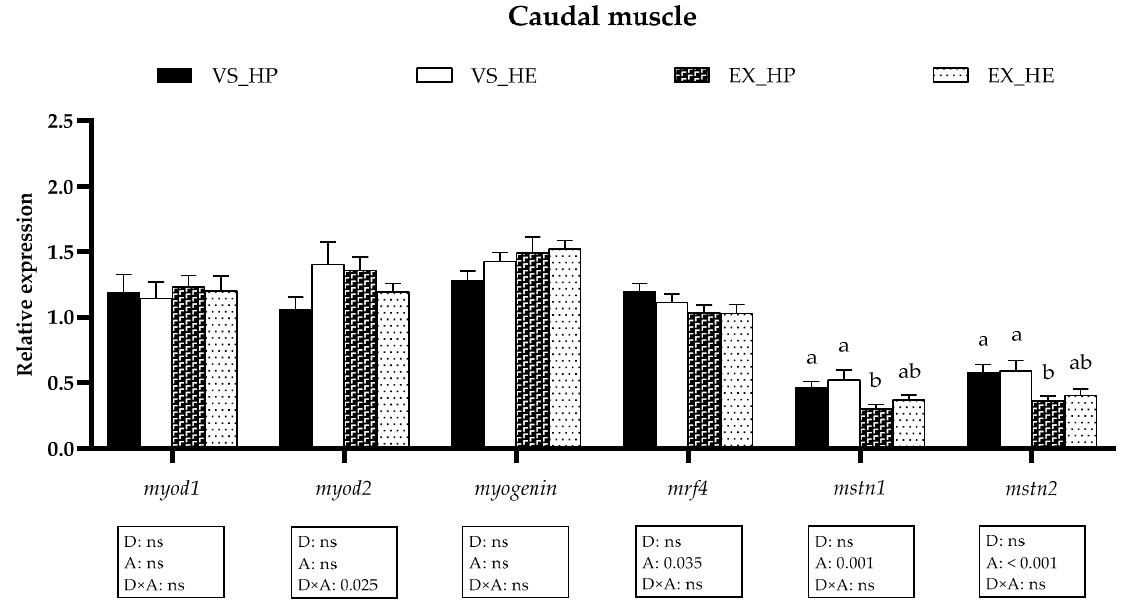
Figure 9. Relative gene expression of myogenic regulatory factors in caudal muscle of fish under voluntary swimming (VS) or sustained exercise (EX) and fed with high-protein diet (HP) or high-energy diet (HE). Data are shown as means + SEM. VS, n = 12; EX, n = 16. Factorial statistical analysis was assessed by two-way ANOVA and p -values of factors diet (D), physical activity (A), and interaction (D × A) are displayed under the graph. Different letters indicate significant differences (Tukey’s post-hoc test, p <